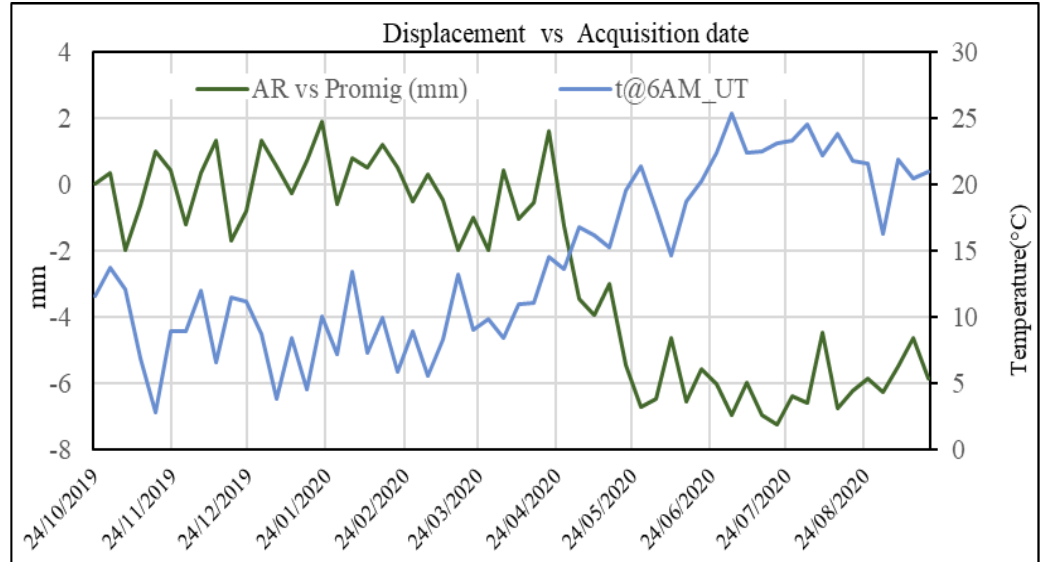
Figure 6. Deformation (green line) and temperature (blue line) time series.